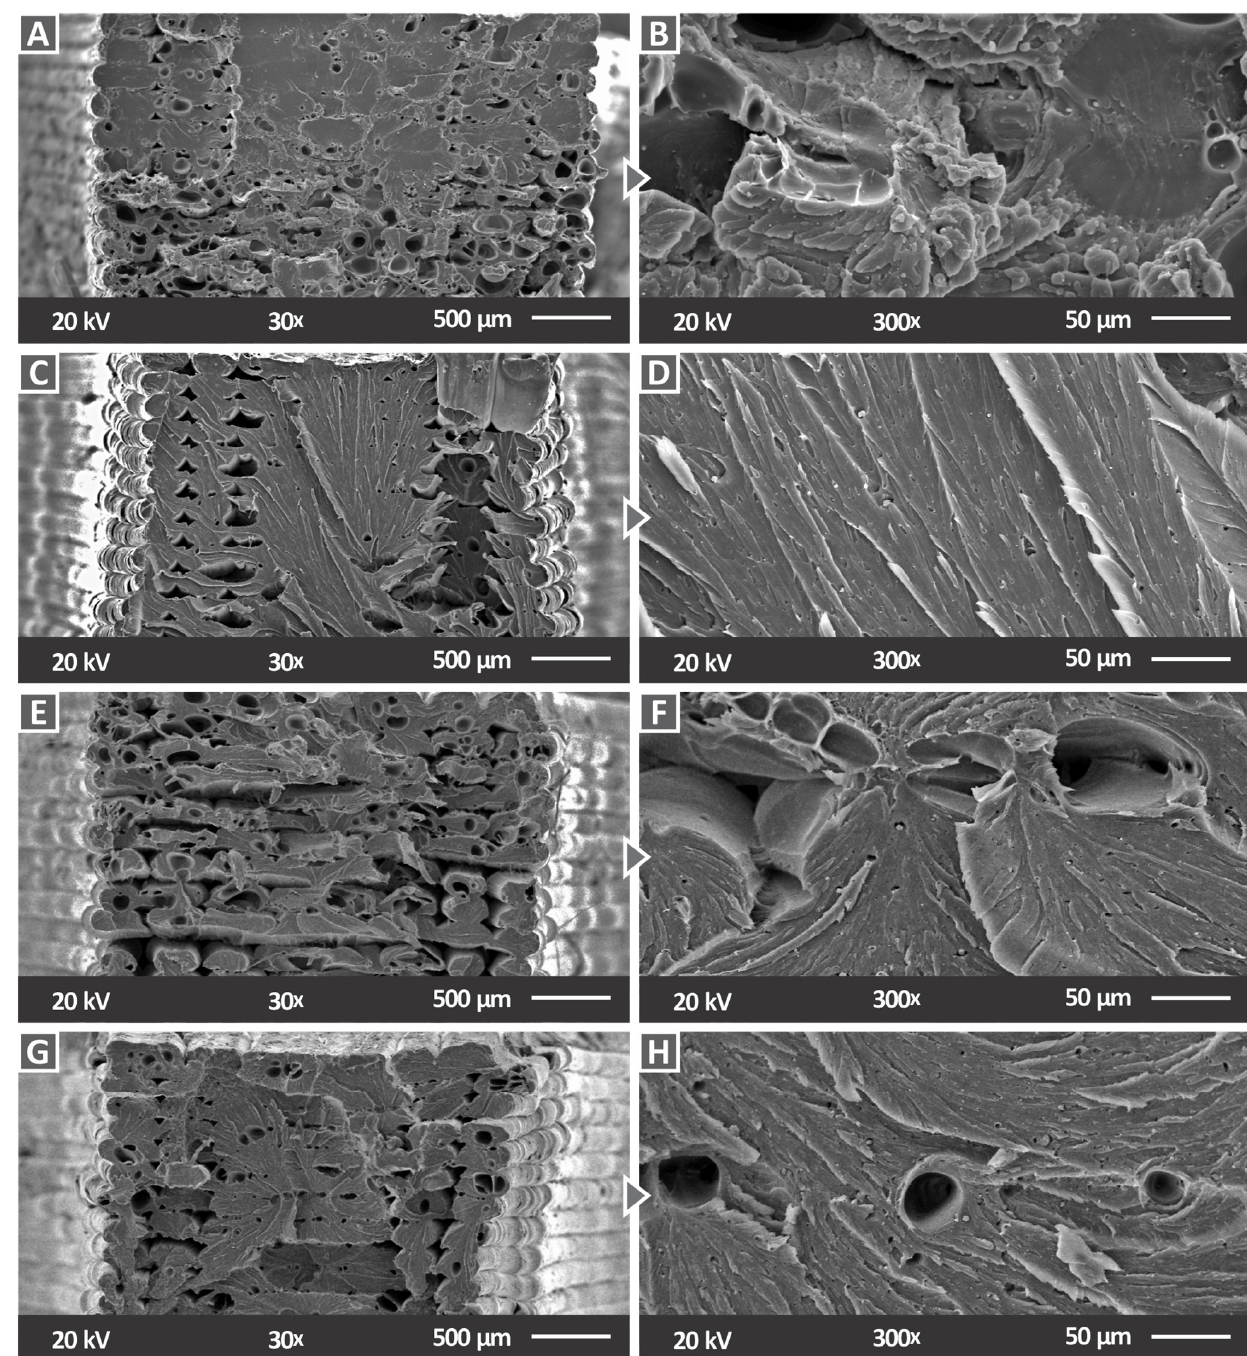
Figure 15. SEM images of fracture surface for ( A ) PC/AlN 1 wt.% with 30× magnification, ( B ) PC/AlN 1 wt.% with 300× magnification, ( C ) PC/AlN 2 wt.% with 30× magnification, ( D ) PC/AlN 2 wt.% with 300× magnification, ( E ) PC/AlN 3 wt.% with 30× magnification, ( F ) PC/AlN 3 wt.% with 300× magnification, ( G ) PC/AlN 6 wt.% with 30× magnification, and ( H ) PC/AlN 6 wt.% with 300× magnification.